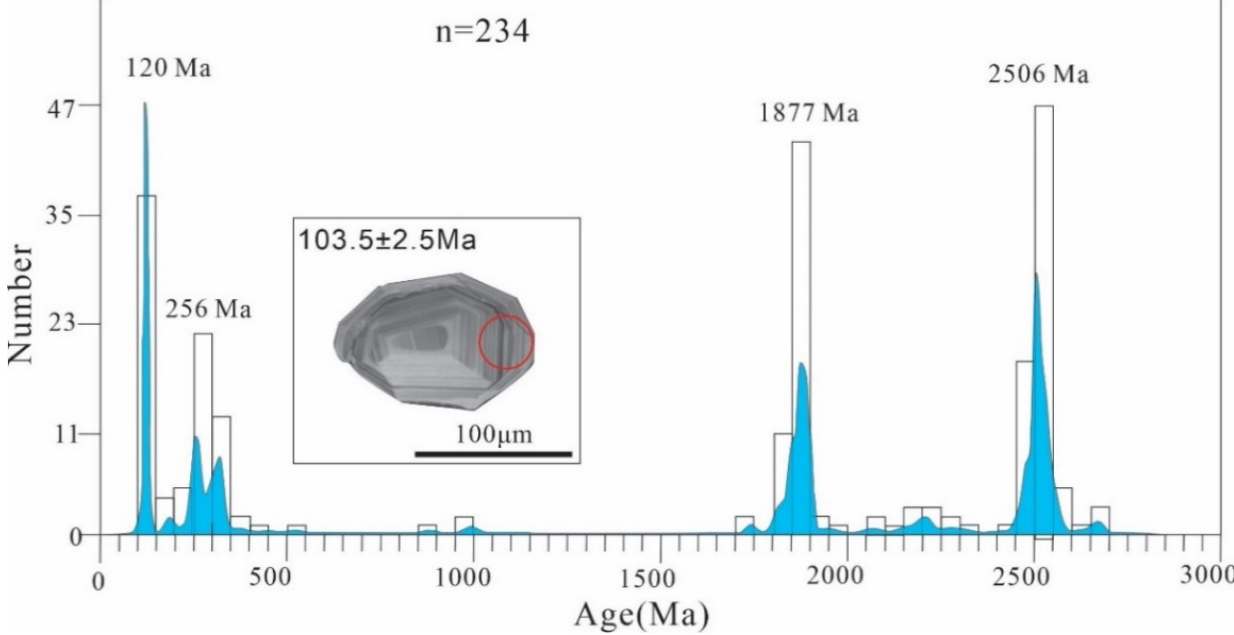
Figure 5. Kernel density estimation plot [22] of detrital zircon U-Pb ages of the sample from C2 core of borehole BZ26-A and CL image of the youngest zircon grain where the red circle marks the site of LA-ICPMS analysis. Data are discretized at a fixed interval (50 Ma).